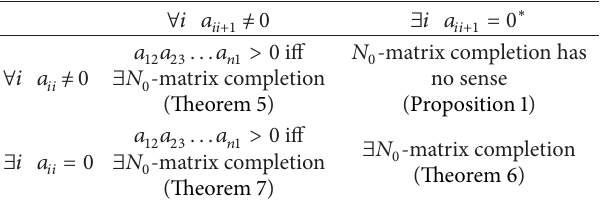
Table 2: ∗ Under the assumption that 𝑎 𝑖𝑖 𝑎 𝑖+1𝑖+1 ̸= 0 implies 𝑎 𝑖𝑖+1 ̸= 0 . ∀𝑖 𝑎 ̸= 0 ∃𝑖 𝑎 𝑖𝑖+1 ∀𝑖 𝑎 ̸=0 𝑖𝑖